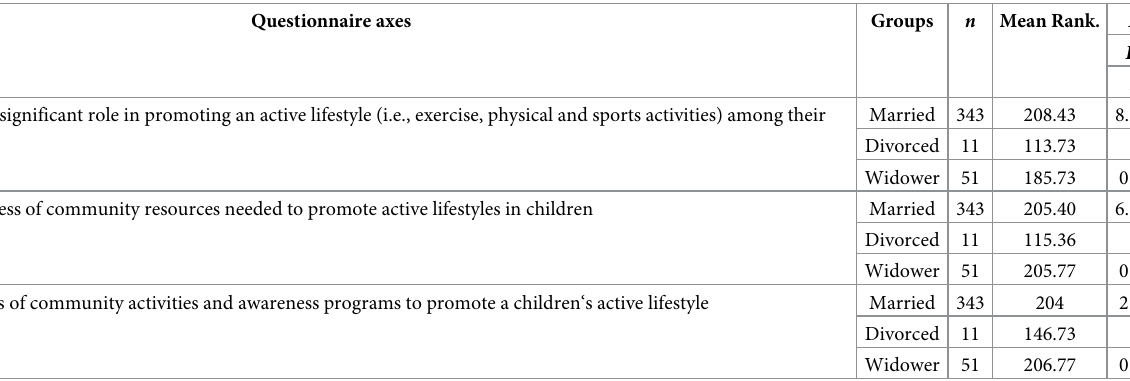
Table 4. Kruskal–Wallis test, the significance of the differences in the mean of sample‘s responses according to Parent‘s Marital status. Questionnaire